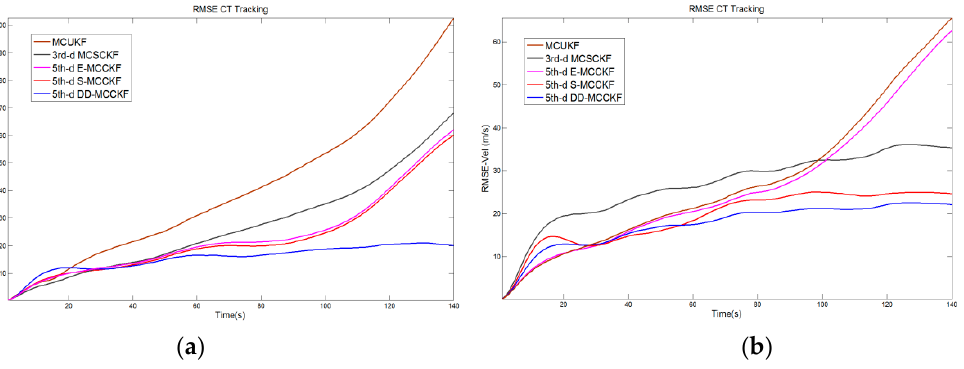
Figure 8. Position RMSEs of robust target-tracking algorithms under non-Gaussian noise conditions (( a ) is the result under Equation (65) and ( b ) is the result under Equation (66)).